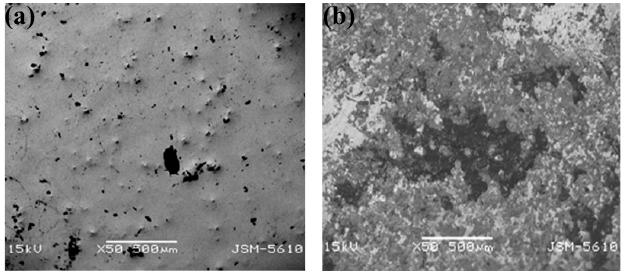
Figure 7. ( a ) Surface corrosion of Fe32Ni36Cr14P12B6 amorphous alloy under artificial saliva. ( b ) Surface corrosion of Fe67Co18B14Si1 amorphous alloy under artificial plasma, reprinted with permission from Ref. [58] 2021, Elsevier. Fe-based amorphous alloys were corroded, but the surface morphology changed little.